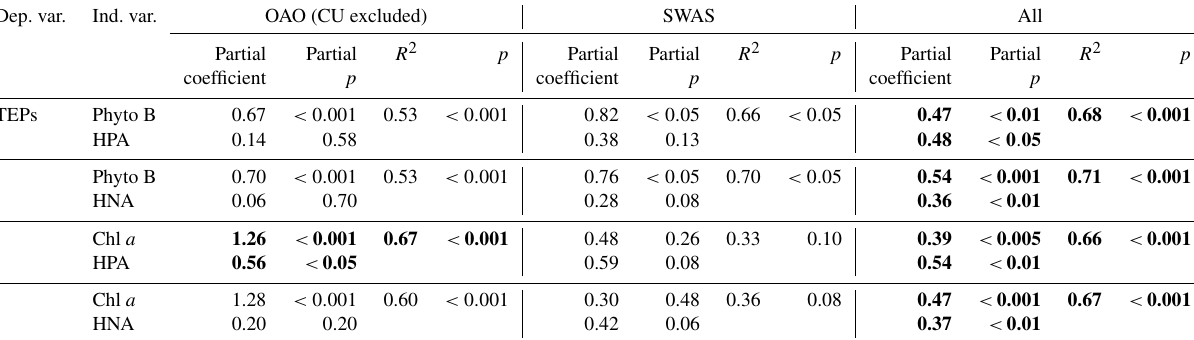
Table 4. Results of multiple regression analyses between TEPs and combined variables, all log 10 transformed. Bold font denotes statistical significance with p < 0 . 05. Dep.